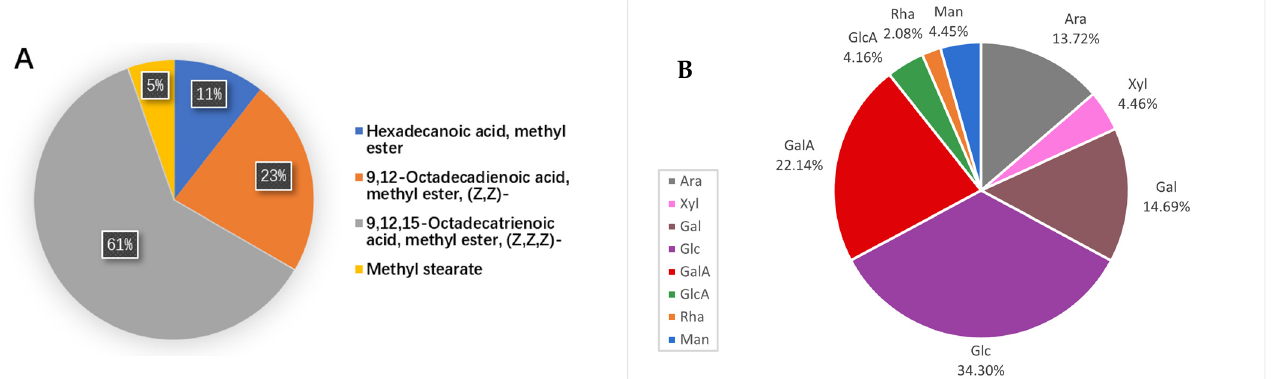
Figure 2. ( A ) Fatty acids composition of F. tikoua fruit. ( B ) The ratio of the monosaccharide compo- sitions of the polysaccharide of F. tikoua fruit. Each monosaccharide composition is shown in a different color.